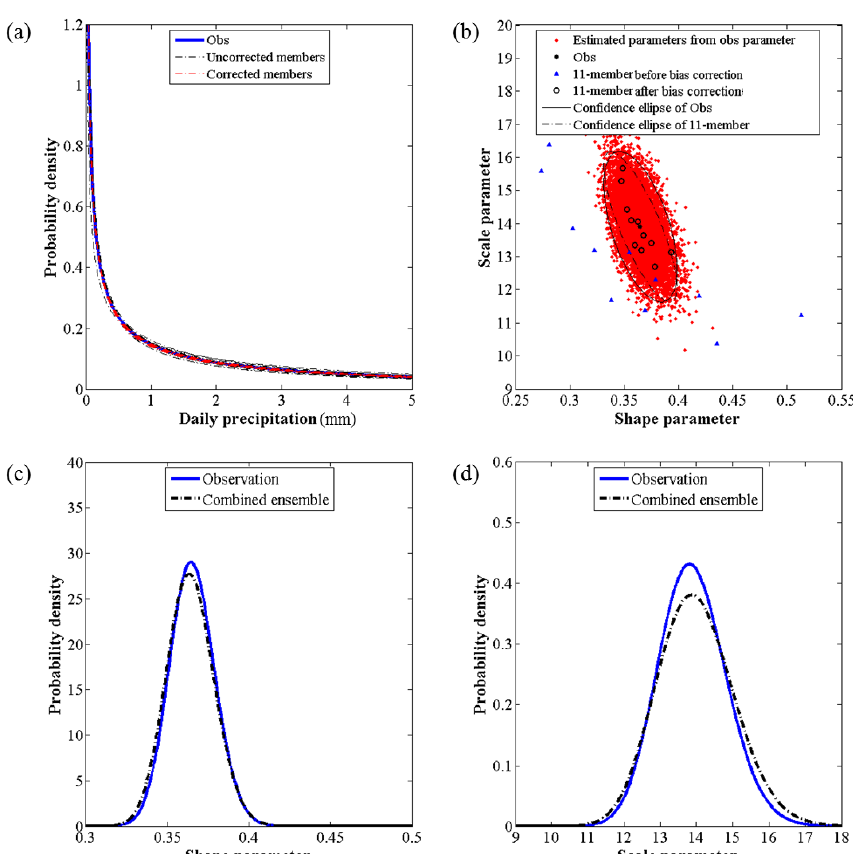
Figure 10. Results of the proposed bias correction method: (a) probability density functions of the observed, bias uncorrected, and bias corrected precipitation; (b) scatter plot between the shape and scale parameters of the observed, bias uncorrected, and bias corrected precip- itation; (c–d) probability density functions of the shape and scale parameters of the observed and bias corrected precipitation.